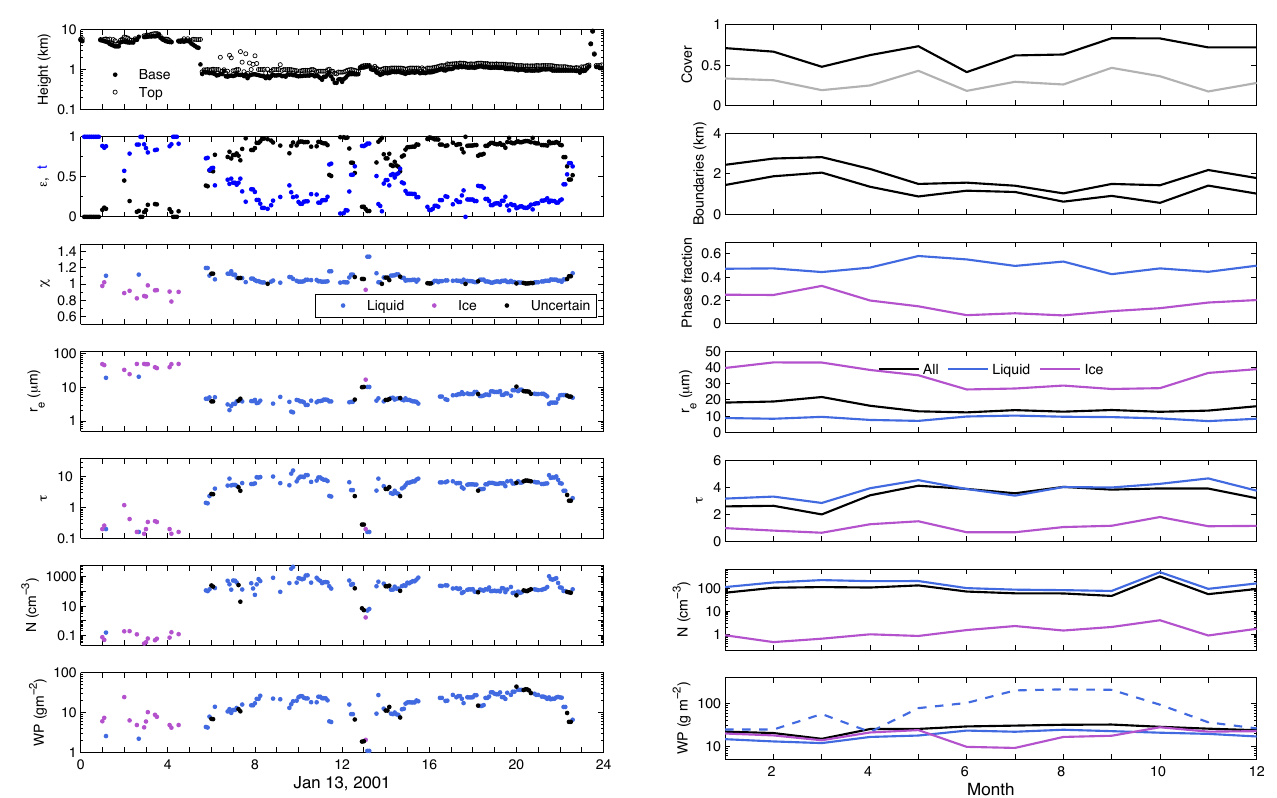
Fig. 16. Monthly averages of retrieved graybody cloud properties for the 2000 to 2003 time period at NSA-AAO. Top panel: retrieved cloud cover of all (black) and graybody (gray) clouds. Lower pan- els: for graybody clouds only, the cloud boundaries, the fraction of clouds that were identified as liquid (blue) or ice (magenta), the cloud particle effective radius r e of liquid, ice and all (black) clouds, the cloud optical depth τ , the cloud particle number concentration (liquid (cm − 3 ), ice (cm − 3 )), and the water path WP. The dashed line for WP represents MWR retrievals for all liquid